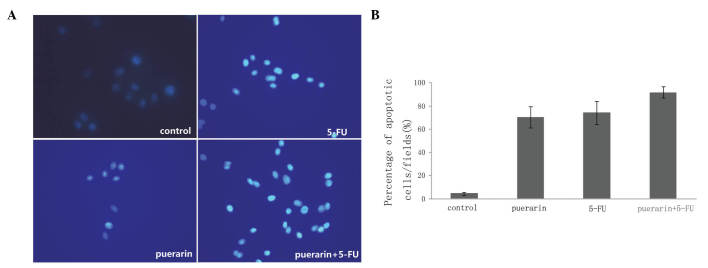
Puerarin and 5-FU either in combination or alone induce apoptosis in BGC-823 cells. (A) Detection of apoptotic morphological changes by Hoechst 33258 staining. Following exposure to puerarin (1,600 μM), 5-FU (80 μM) or puerarin+5-FU for 48 h, BGC-823 cells were incubated with 20 μM Hoechst 33258 for 10 min at room temperature. Then apoptotic features were assessed by observing chromatin condensation and fragment staining. (B) Quantification of results. *P<0.05 compared with the control group and #P<0.05 compared with peurarin or 5-FU. Magnification, ×400. 5-FU, 5-fluorouracil.